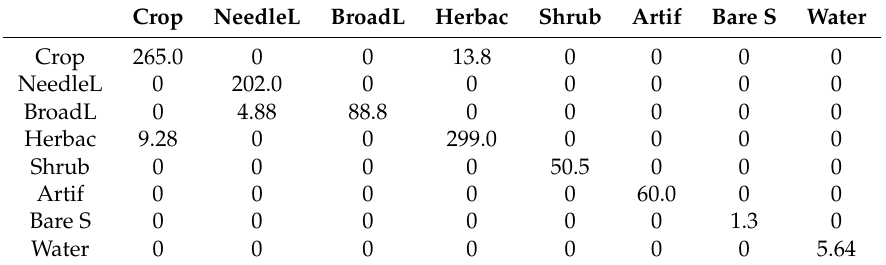
Table A7. Confusion matrix for the reference obtained by photointerpretation and validated on the field.